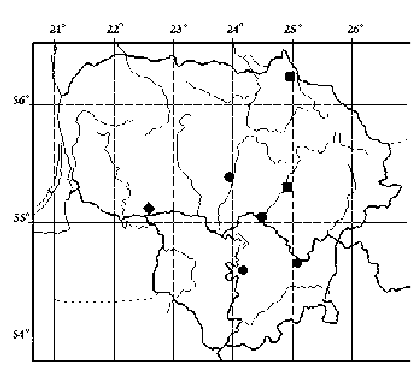
Fig. 7. Localities of E. arboreum (■), E. brooksii (●), and E. corynophorum (♦) in